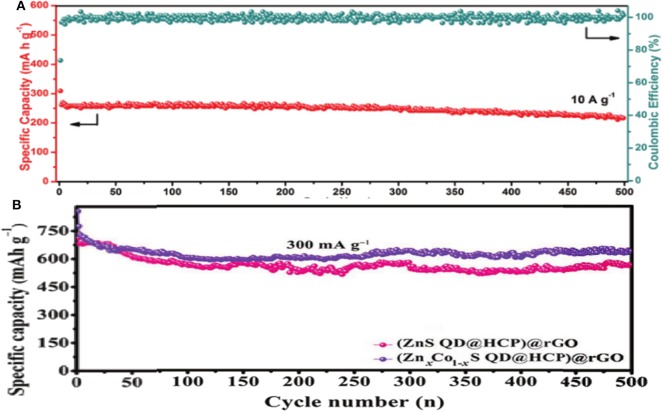
(A) Cycling performance of Co1Zn1-xS. Reproduced with permission from Fang G. et al. (2018) Copyright 2018. Wiley-VCH. (B) Cycling performance of (ZnS QD@HCP)@rGO and (ZnxCo1−xS QD@HCP)@rGO composites at 3 A g−1. Reproduced with permission from Chen Z. et al. (2017) Copyright 2017. Wiley-VCH.